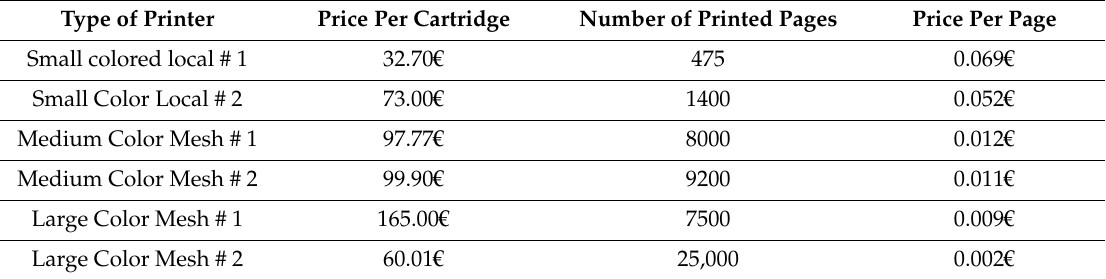
Table 1. Comparison of prices of printed pages for di ff erent types of